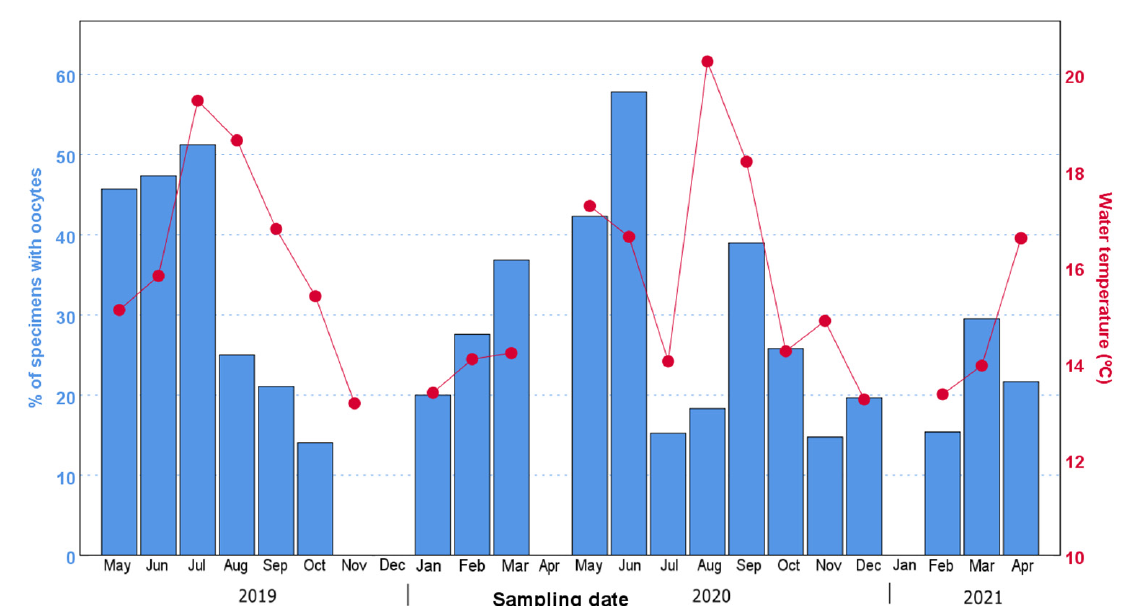
Figure 4. Temporal variation in the percentage of specimens with oocytes (bars) and the water temperature (dots and lines) over the 2-year period studied in this work. The months without data are due to problems derived from COVID-19, or to months in which the weather did not allow us to collect samples.